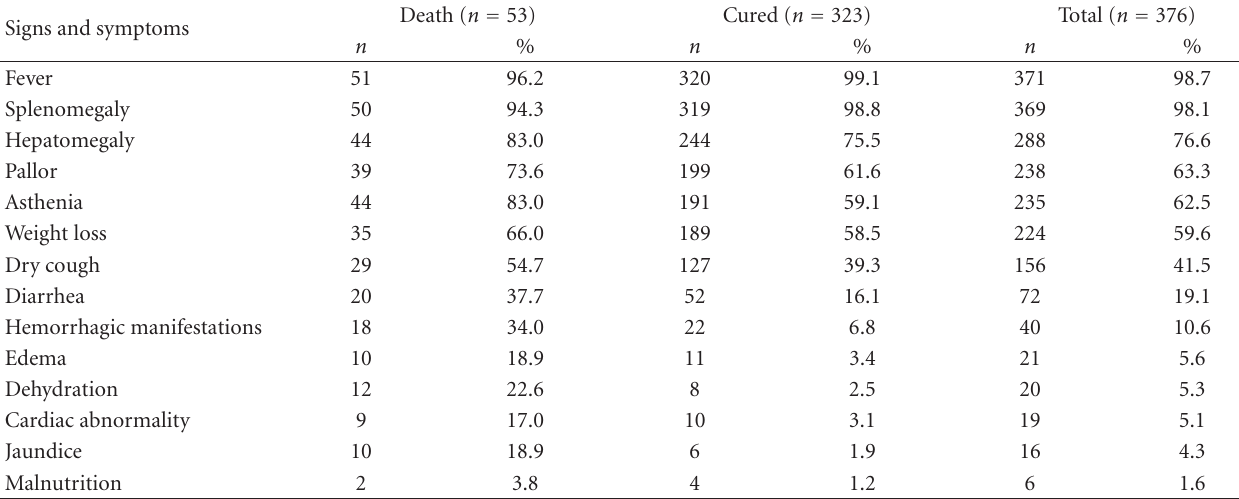
Table 2: Visceral leishmaniasis distribution ( n = number and %) of the main signs and symptoms, according to the clinical outcome of the confirmed cases, state of Sao Paulo, 1999–2005. Signs and